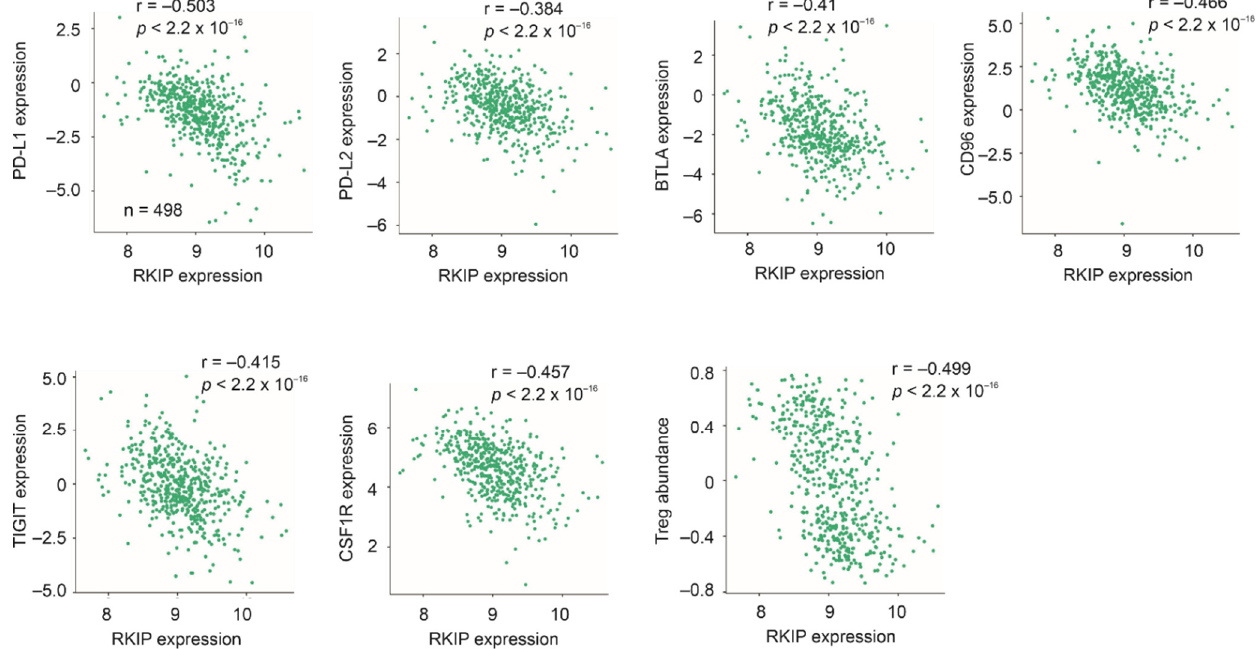
Figure 5. Negative associations of RKIP expression with the indicated immune checkpoints, CSF1R, and Treg (T regulatory cells). Images were produced using TISIDE. Spearman r (correlation coefficient) for the individual correlations are indicated. TCGA dataset ( n = 498) was used. Table 1. Negative correlations between RKIP and PD-L1 and PD-L2 in cancers a .